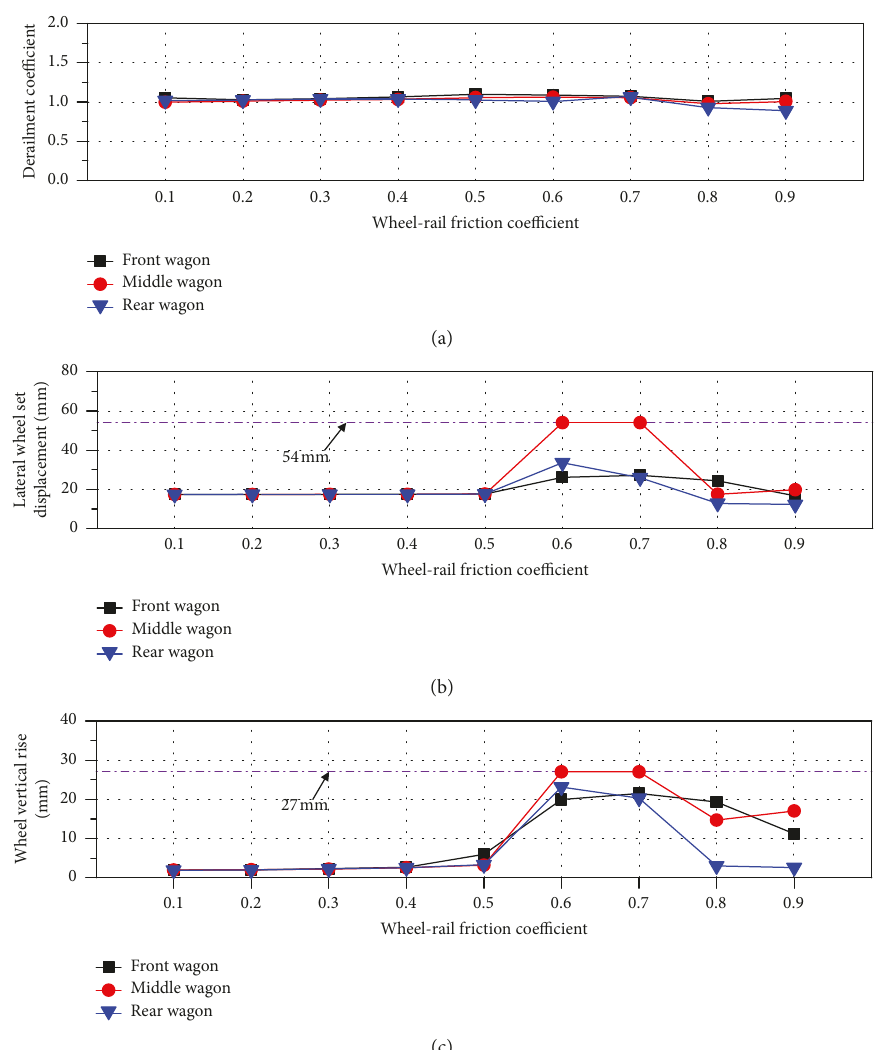
Figure 19: Effects of different wheel-rail friction coefficient on (a) derailment coefficient, (b) lateral wheelset displacement, and (c) wheelset vertical